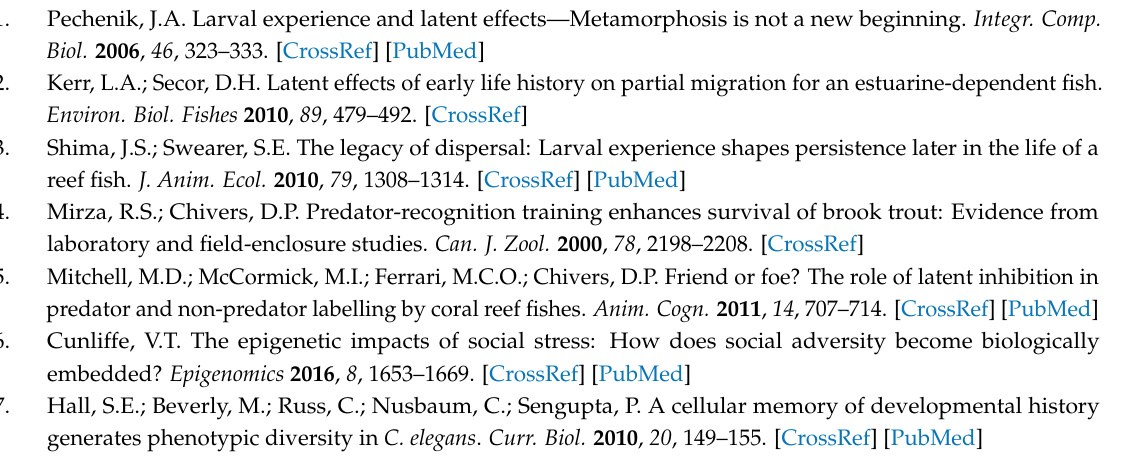
sampling site; Figure S3: Sampling equipment; Figure S4: Inferior lobe dissection protocol; Figure S5: Experimental confirmation of DNA methylation; Figure S6: Bioinformatic confirmation of DNA methylation; Figure S7: Outlier identification. Figure S8: Volcano plots; Figure S9: Differential promoter methylation; Table S1: Growth and luminosity data from the Bay of Gdansk; Table S2: Peak data; Table S3: Candidate genes and candidate processes linked to alternative reproductive strategies in fish from the literature; Table S4: Blast